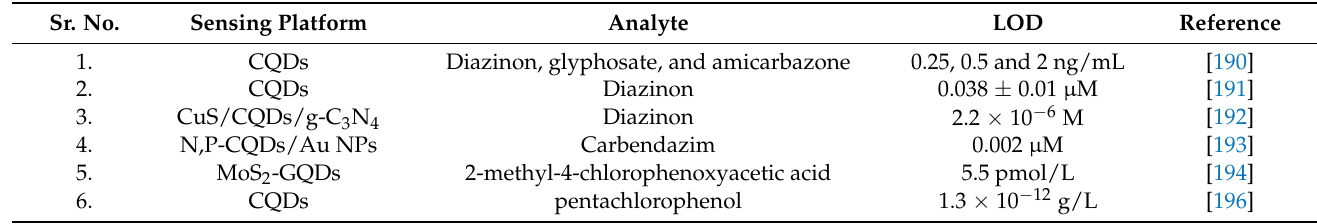
Table 2. Sensing behavior of CQDs and GQDs for detection of